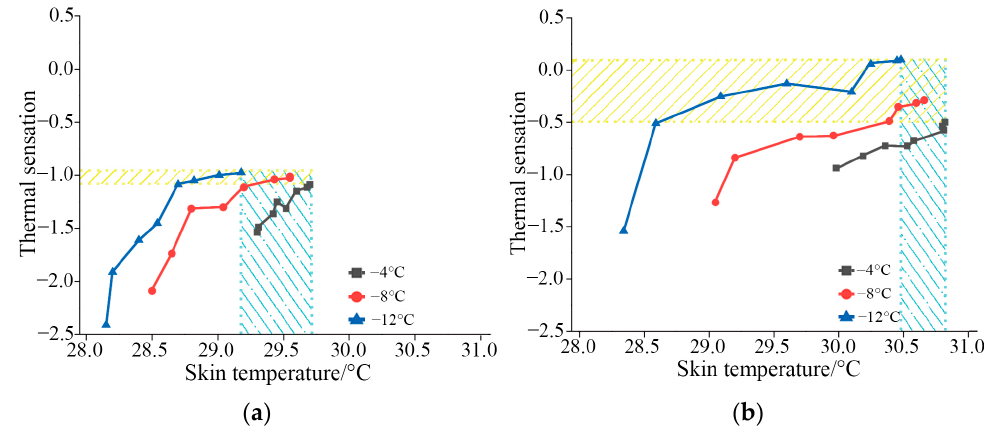
Figure 9. Relationship between mean skin temperature and human thermal sensation. ( a ) Low activity; ( b ) high activity.